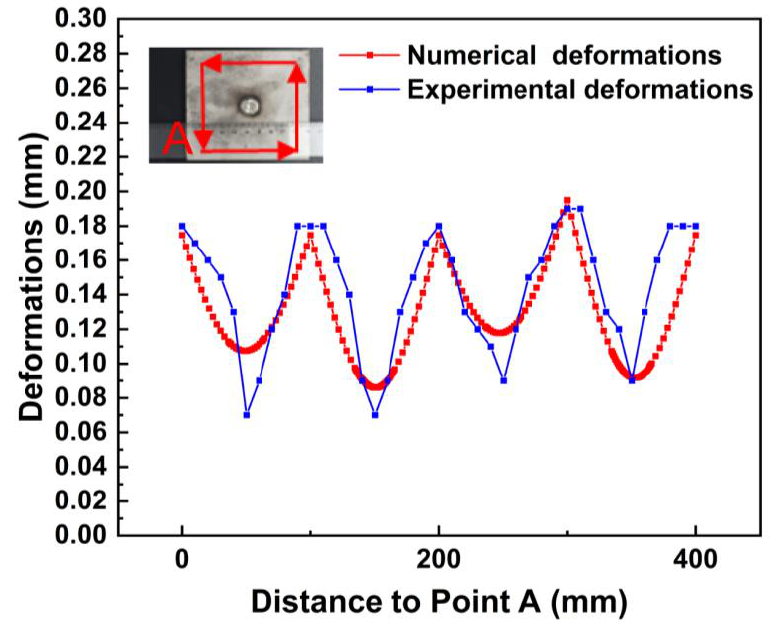
Figure 9. Comparison between numerical and experimental deformations.